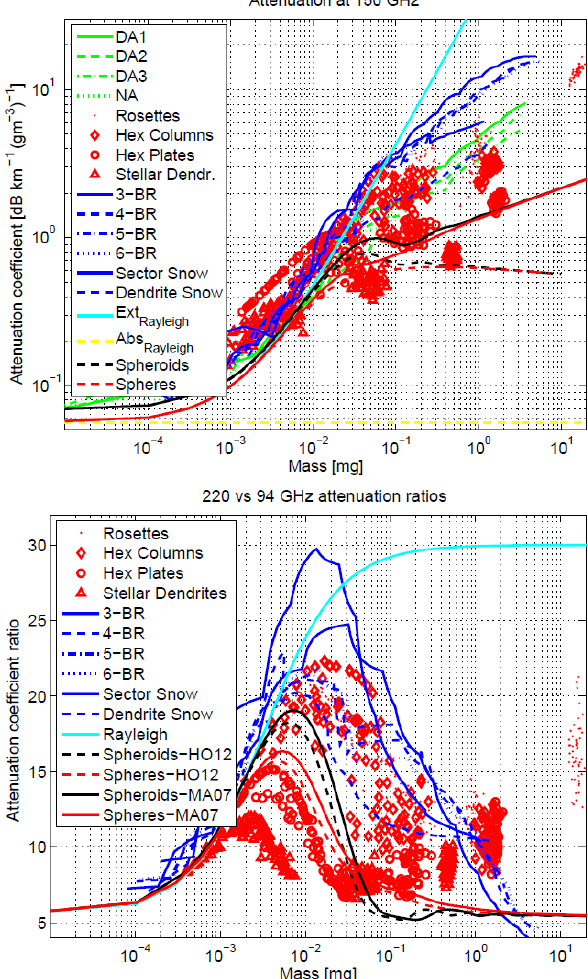
Figure 3. Top panel: one-way mass snow attenuation coefficient